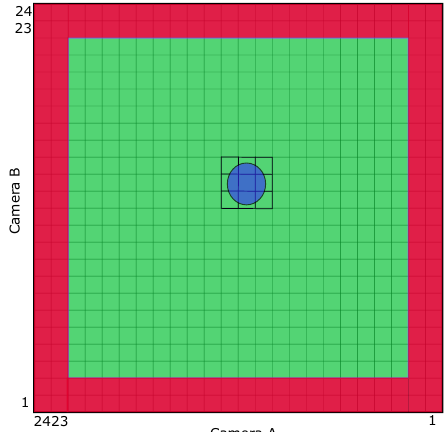
Figure 4. A cartoon showing how the effective sample area should be calculated for a drop covering 3 pixels along both camera axes. Pixels colored red are places that the droplet center could not have fallen and been successfully detected by the 2DVD, whereas pixels colored green show places that the droplet center could have been located and still had the 1 pixel of unshadowed area necessary to detect and properly size the